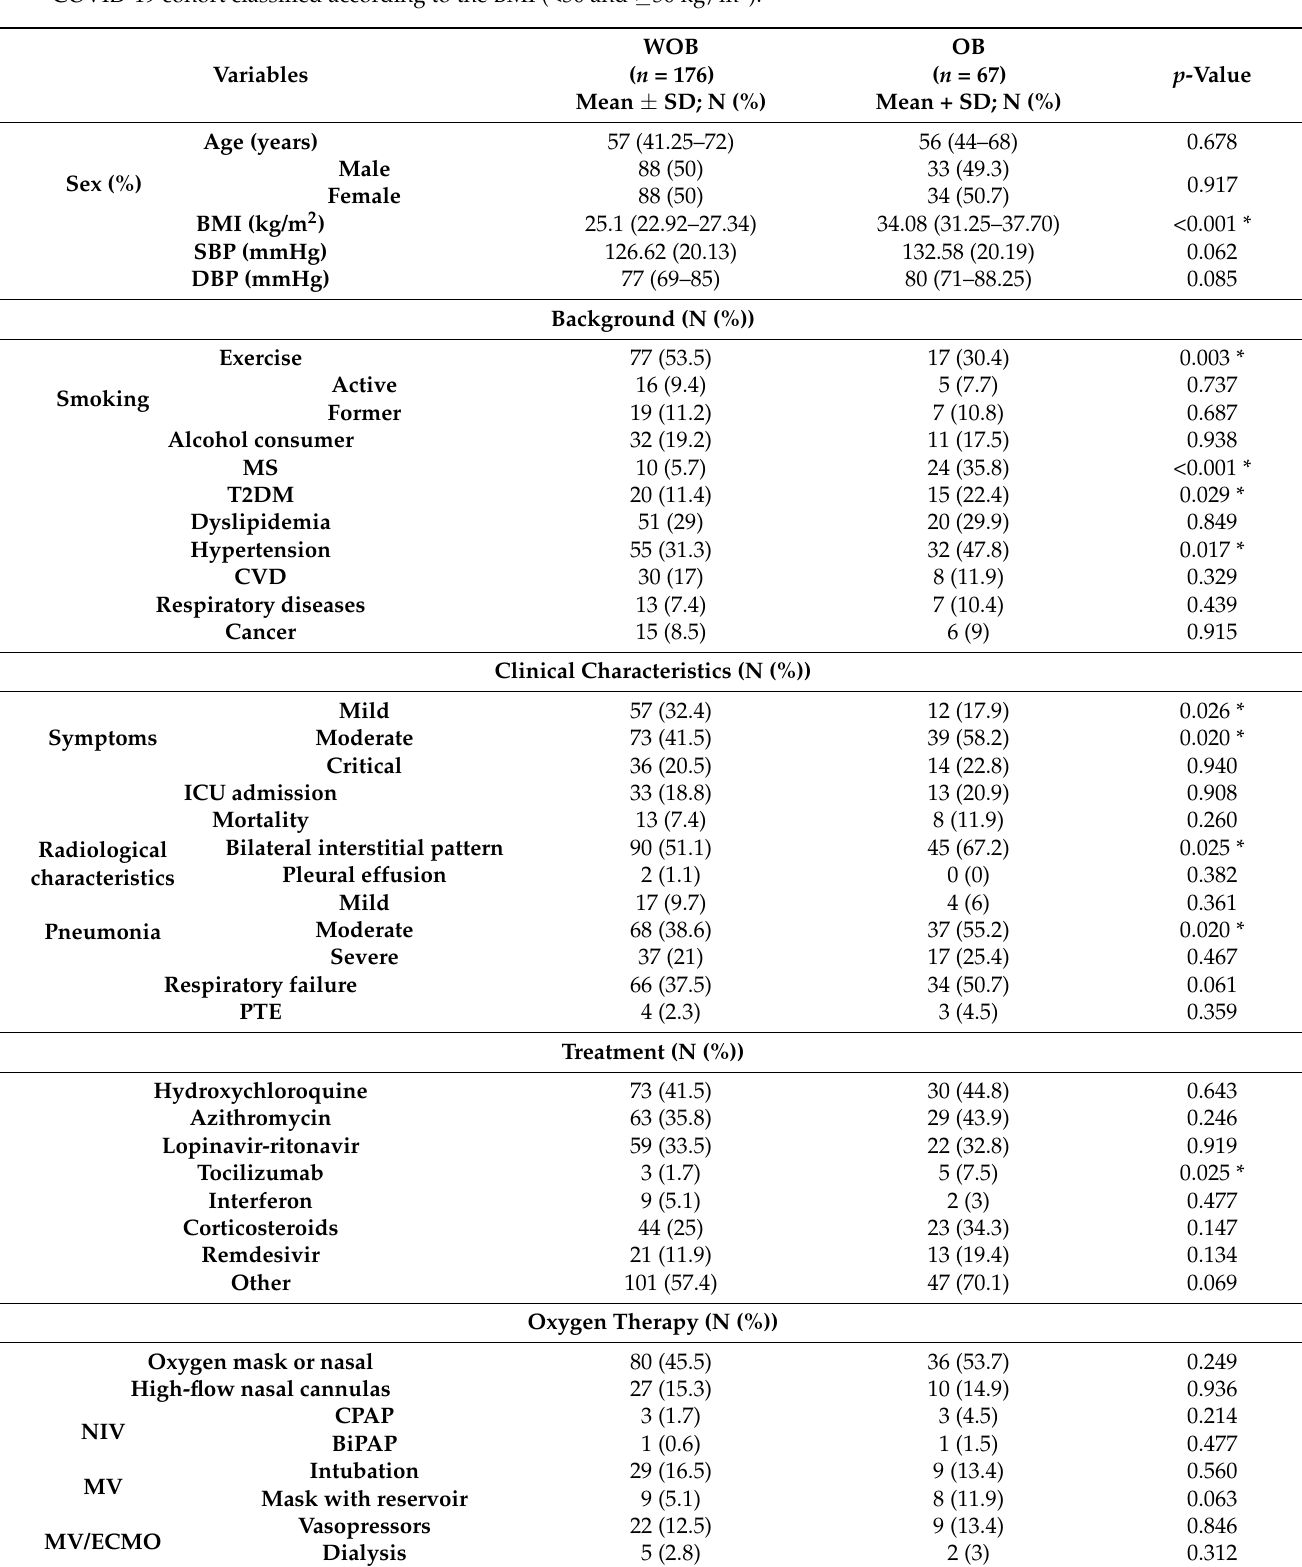
Table 1. Background, comorbidities, COVID-19 treatment, and anthropometric, clinical, and biochemical variables of the COVID-19 cohort classified according to the BMI (<30 and ≥ 30 kg/m 2